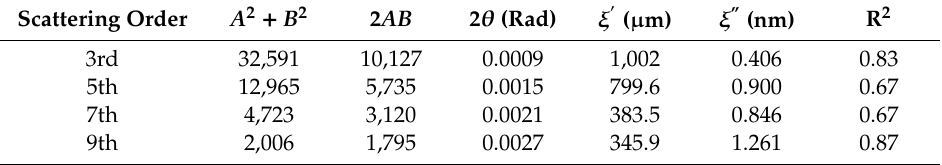
Table 1. The scattering intensities A 2 , B 2 of the grating sample and the NIST SRM 3600, respectively, the calculated values for 2 AB , the peak position in scattering angle, the best-fit values of the e ff ective longitudinal coherence length, and resulting values for ξ (cid:48)(cid:48) are listed for four peak positions. Scattering Order A 2 + B